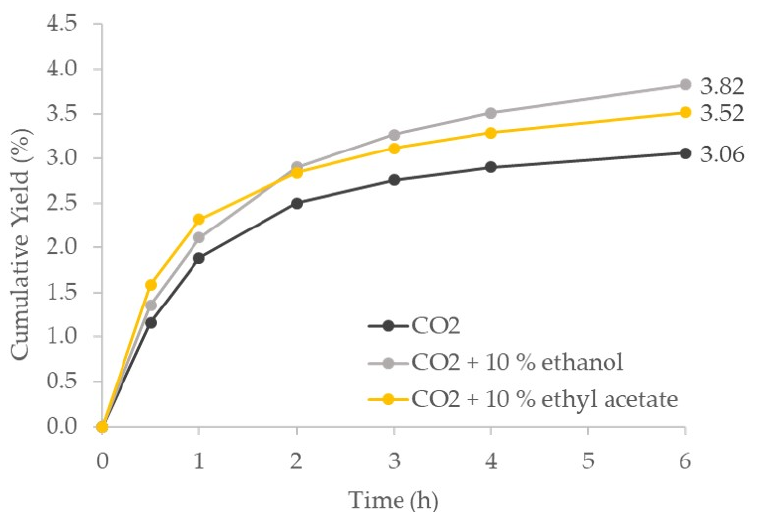
Figure 6. Extraction curves of tomato pomace using pure CO 2 , CO 2 with 10% ethanol and CO 2 with 10% ethyl acetate at 300 bar/60 °C/12 g/min CO 2 /6 h with no particle size reduction.